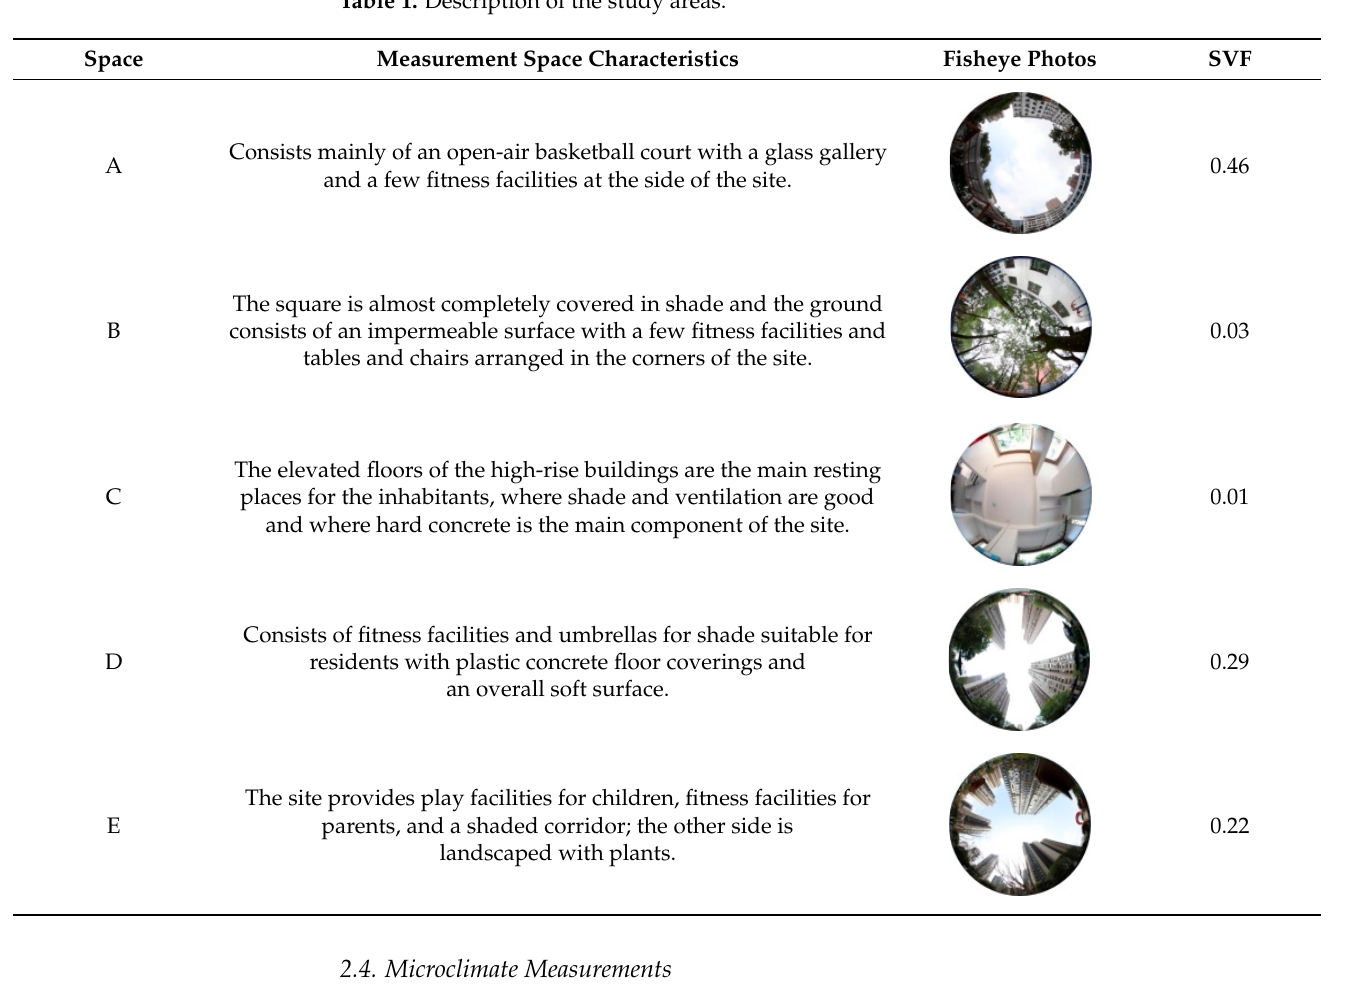
Table 1. Description of the study areas.